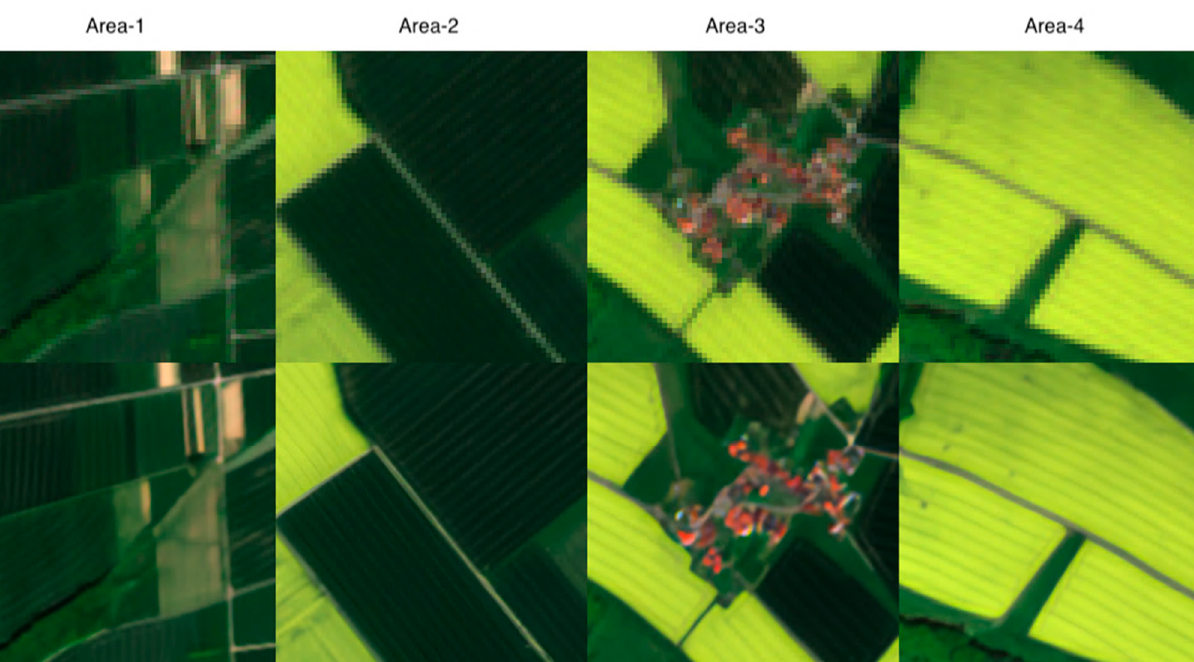
Figure 9. Cropped examples ( 625𝑚 × 625𝑚 ) of the 10m/pixel Sentinel-2 “true” colour images (L1C) and TARSGAN SRR result over Hainich, Germany (Site-3). Please refer to supplementary material for full-size SRR (produced from Sentinel-2